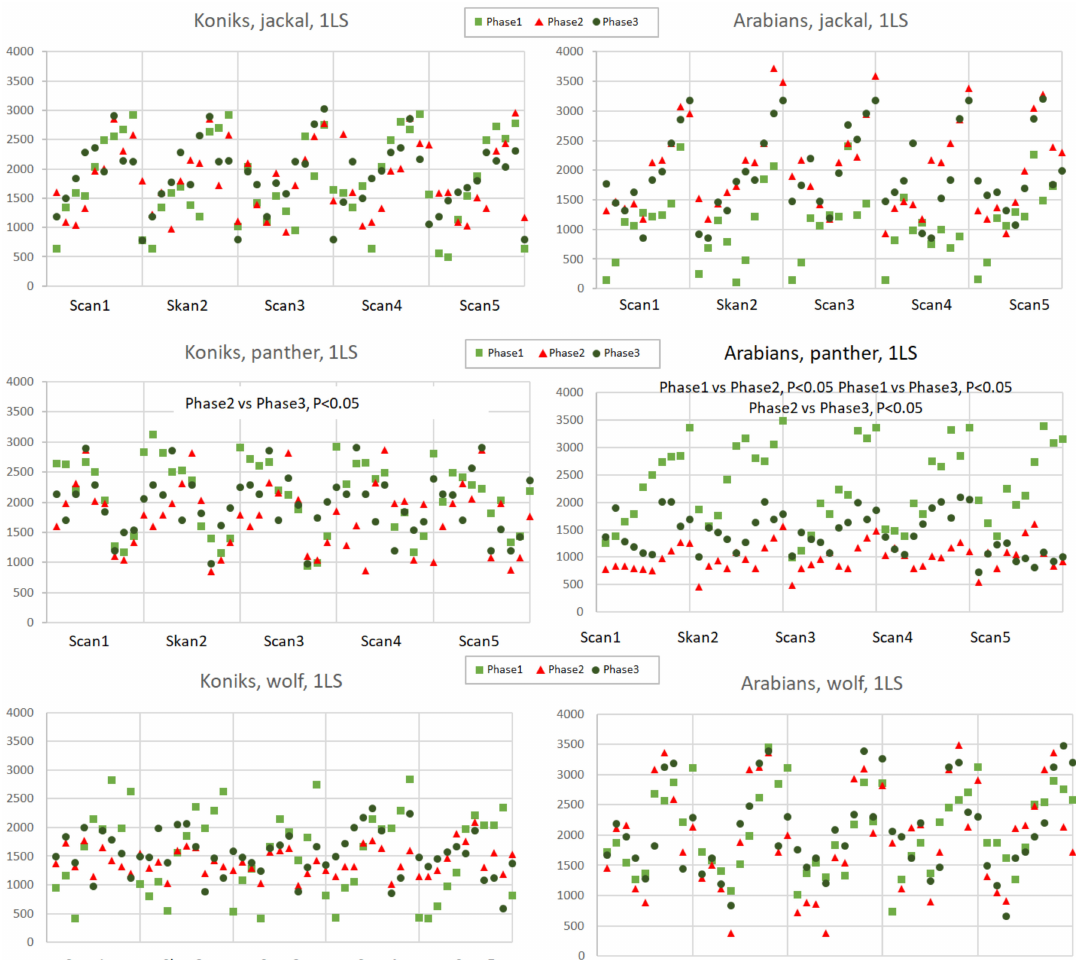
Figure A3. Distance to the nearest loudspeaker (DIST-LS, cm) in Koniks and Arabians in response to jackal’s, leopard’s and wolf’s vocalisation played from 1LS in pre-, playback and post-playback phases. Each point represents the distance of individual horse the nearest LS. Phases are depicted with light green squares (phase 1, pre-playback), red triangles (phase 2, playback) and dark green circles (phase 3, post-playback). Only significant di ff erences between phases were shown in the